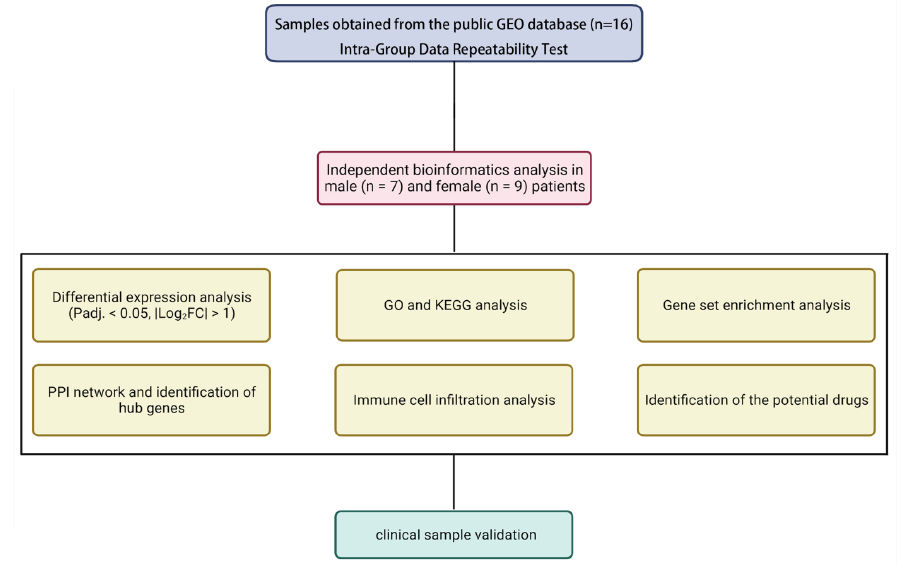
Figure 1. The flowchart of this research analysis.